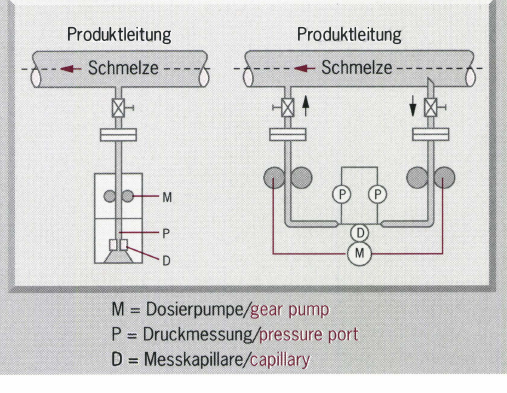
2 On-Line Determination of the Melt